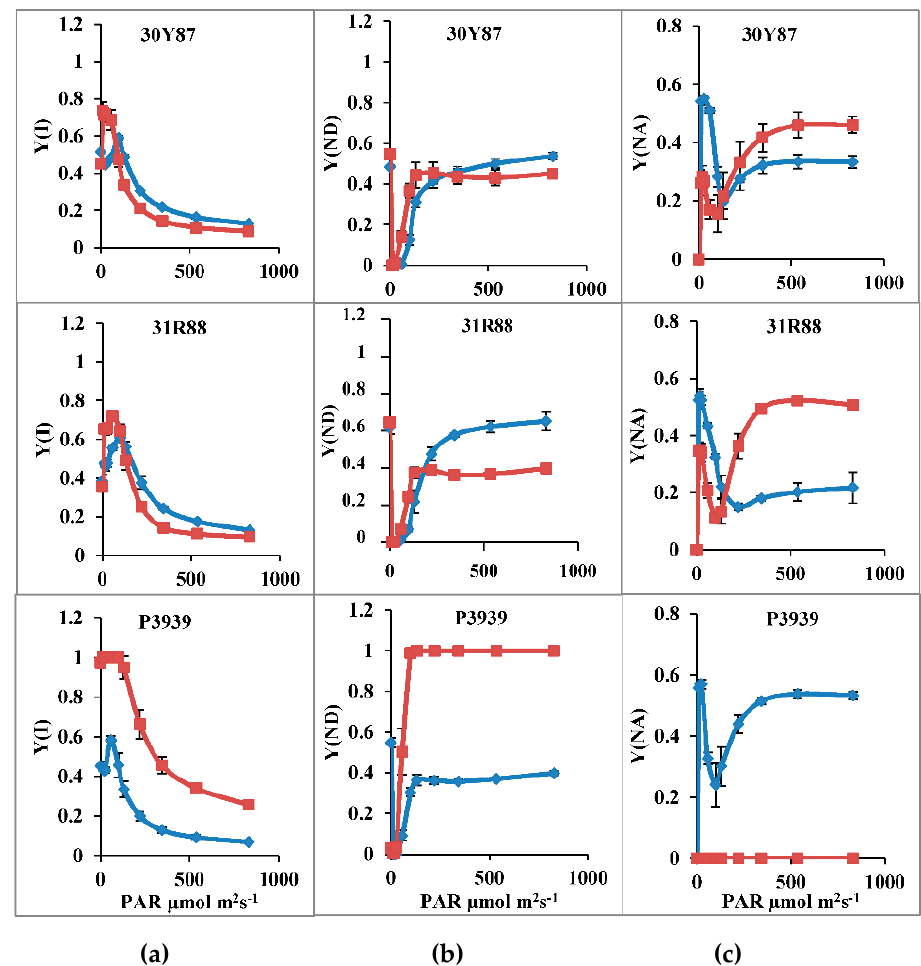
Figure 4. Activity of PSI of three maize hybrids when two-week-old plants were subjected to three cycles of drought stress. ( a ) Effective quantum yield of photosystem I [Y(I)] ( b ) fraction of overall P700 that is oxidized in a given state [Y(ND)] ( c ) Fraction of overall P700 that cannot be oxidized in a given state [Y(NA)]. Blue lines are control, red lines with markers are water stress. Bars represent the calculated standard error (n = 4).